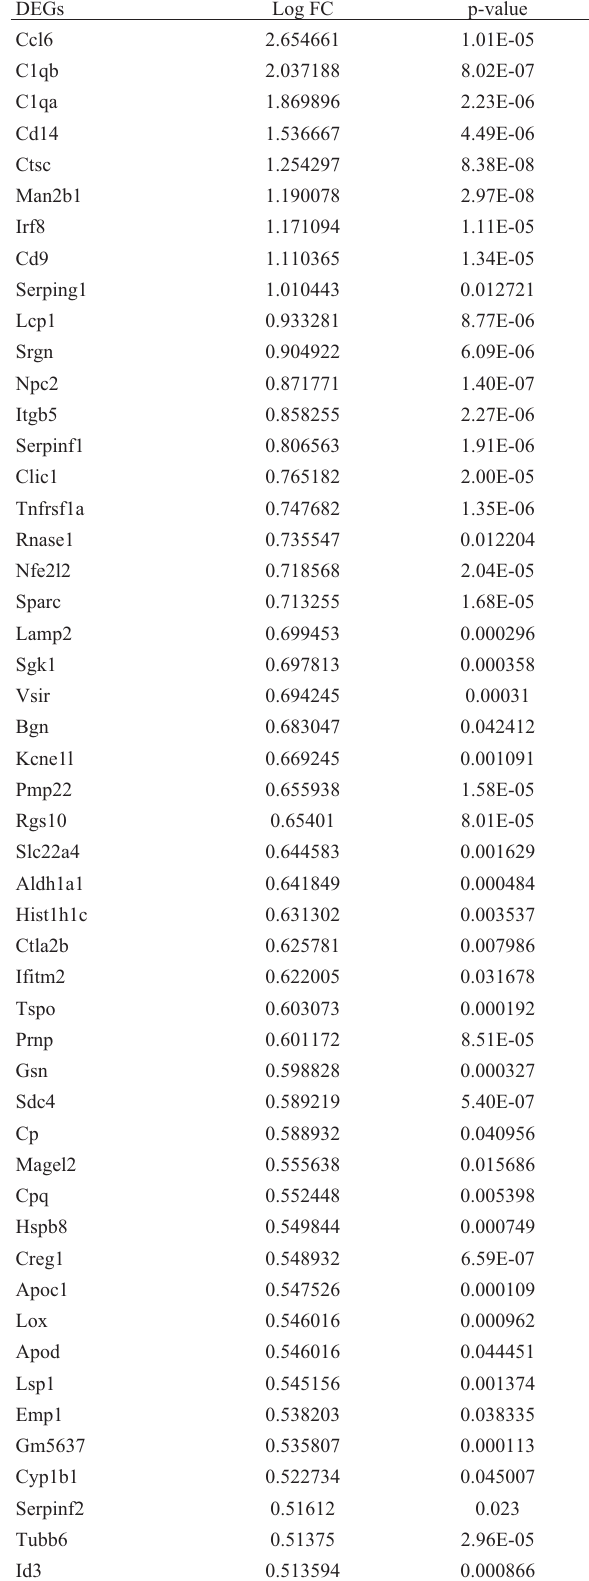
Table 1 - The top 50 up-regulated DEGs in AD mice compared with wild-type